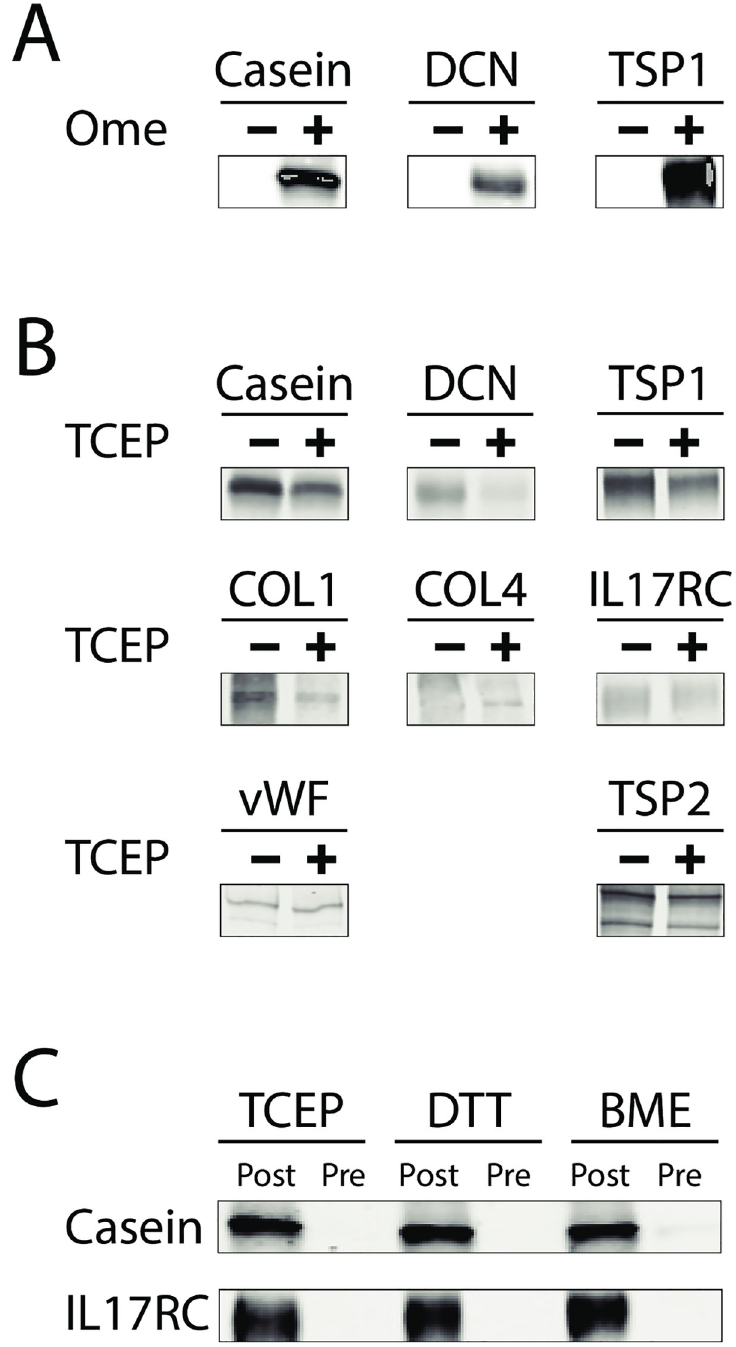
Fig 4. Formation of omeprazole complexes with purified proteins. (A) The ability of omeprazole to form complexes with purified proteins was tested by incubation of 1mM omeprazole with casein, DCN, and TSP1 for 2hour at 37˚C (non-reducing SDS-PAGE). Western blot analysis with monoclonal antibody indicates that the antibody binds only to the omeprazole containing complexes. (B) Pre-reduction of expanded set of purified proteins with 2.5mM TCEP beads for 1hr at 37˚C does not significantly increase the recognition by the anti-omeprazole monoclonal antibody. For all proteins tested, the formation of omeprazole-protein complexes occurs in the absence of reducing agents (non- reducing SDS-PAGE). (C) Effect of reductants on Ome-protein complex formation. All reactions were performed with 2.5mM reductants added either before or after omeprazole was mixed with proteins. When reducing agents were co- incubated with omeprazole and proteins from the initial complex formation (an individual protein was incubated